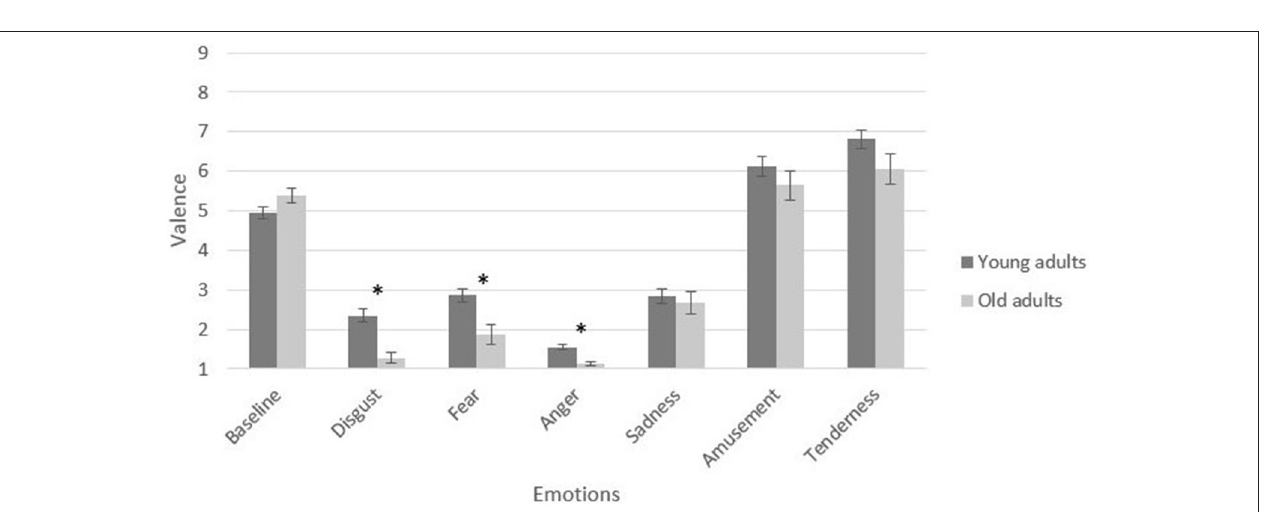
Frontiers in Psychology |